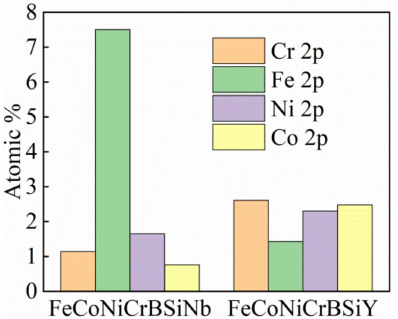
Figure 11. Atomic percentage of each element in passivation films on the FeCoNiCrBSiNb and FeCoNiCrBSiY coatings.